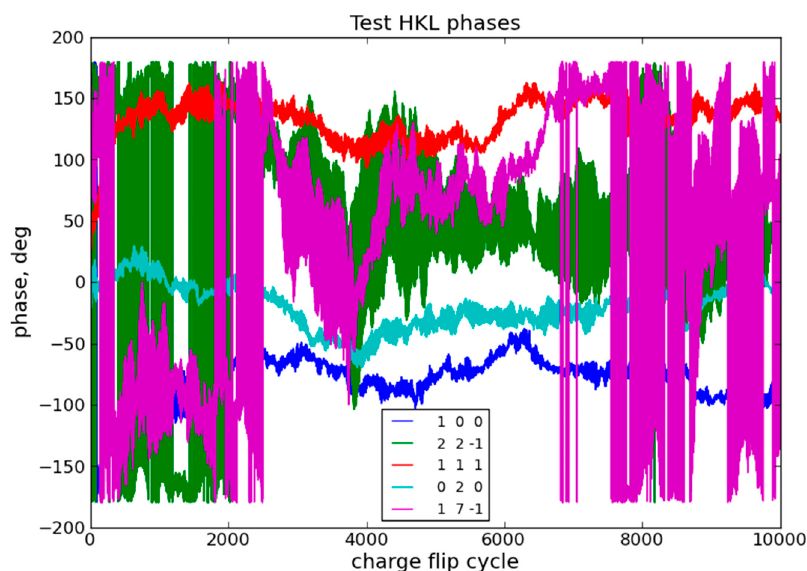
Figure 9. Phases of five reflections from an unsuccessful charge flipping run for sucrose. The residual stayed above ~40% for 10,000 CF cycles.